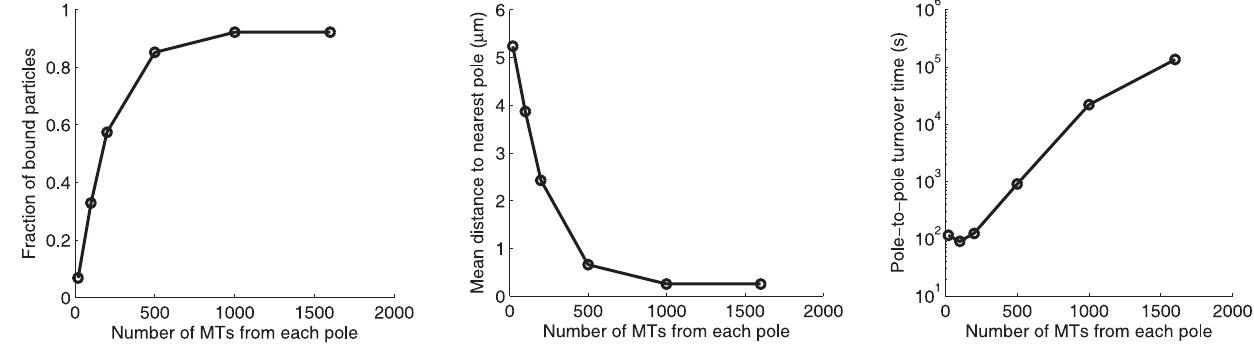
Figure 2. Effects of microtubule density on the spatial regulation. The sequestration (fraction of particles bound), concentration (inverse of mean distance to MTOC) and pole-to-pole turnover time increases, as microtubule density increases.